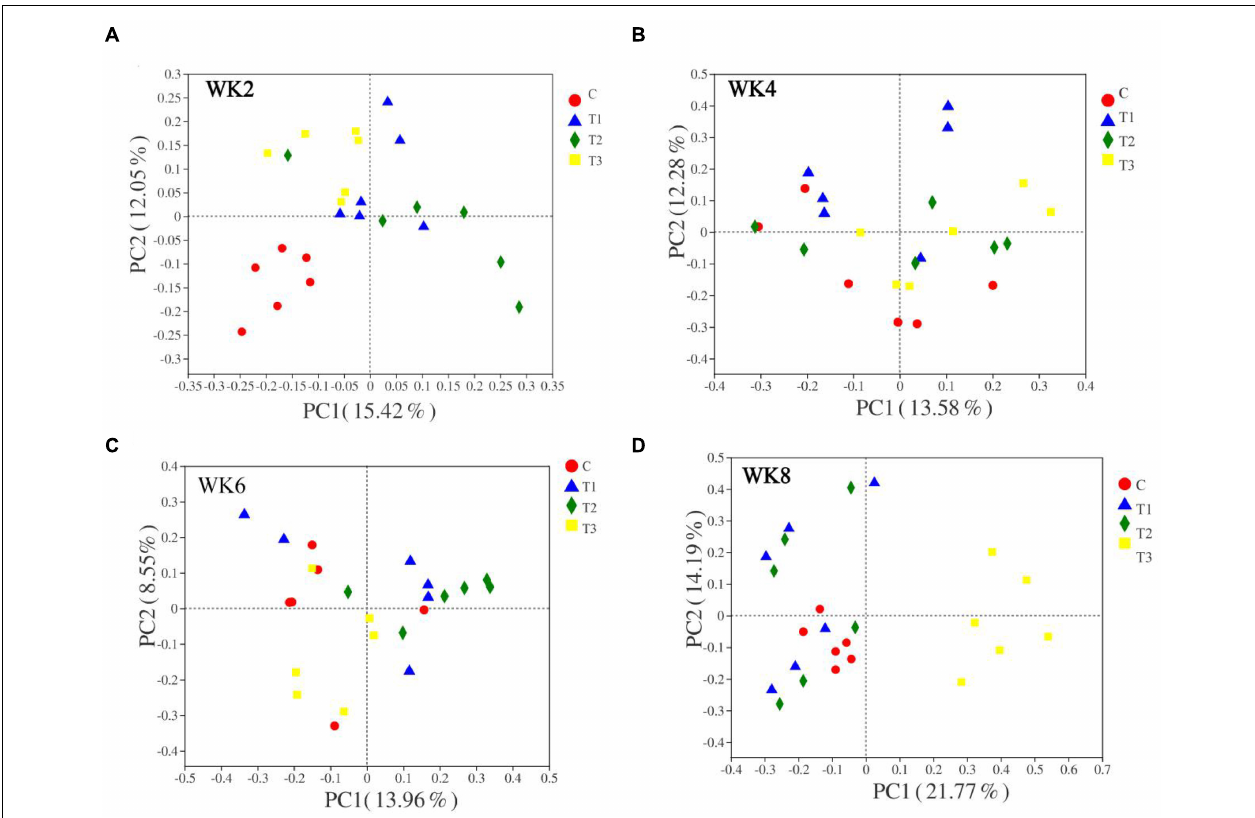
FIGURE 1 | Based on Bray–Curtis distance principal coordinates analysis (PCoA) (Panels A–D indicate WK2, WK4, WK6, and WK8 bacteria PCoA pictures).